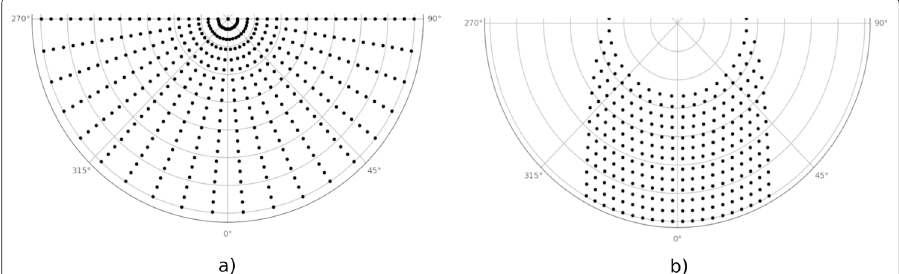
Fig. 6 Polar projection of the position of the lamp over the surface of the virtual sphere. a) Positions without angular correction, which implies that the distance between points change as a function of zenith angle. b) corrected position using equation 1, which allows for a constant distance between